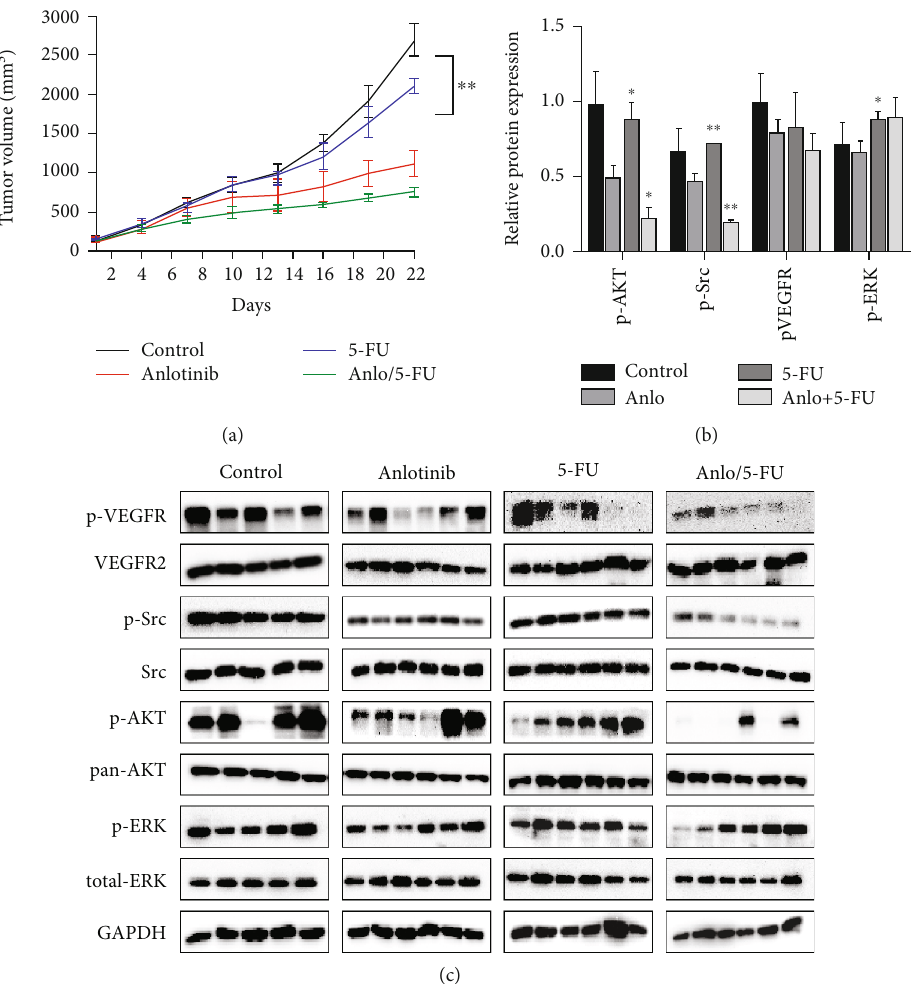
Figure 6: Anlotinib combined with 5-FU a ff ected cell proliferation and angiogenesis in vivo. 24 male BALB/c-nu mice were randomly divided into four groups treated with oral saline, 1.5 mg/kg anlotinib, 100mg/kg 5-FU, or both of anlotinib and 5-FU. (a) Tumor volume in mice after 21-day treatment. (b) The protein expression for each group. (c) The relative protein expression levels of each group. The results are from three independent experiments. ∗ P < 0 : 05 and ∗∗ P < 0 : 01 compared with